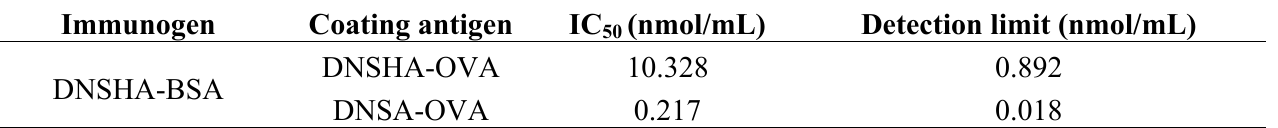
Table 1. Indirect ELISA evaluation for DNSH with different coating antigens.